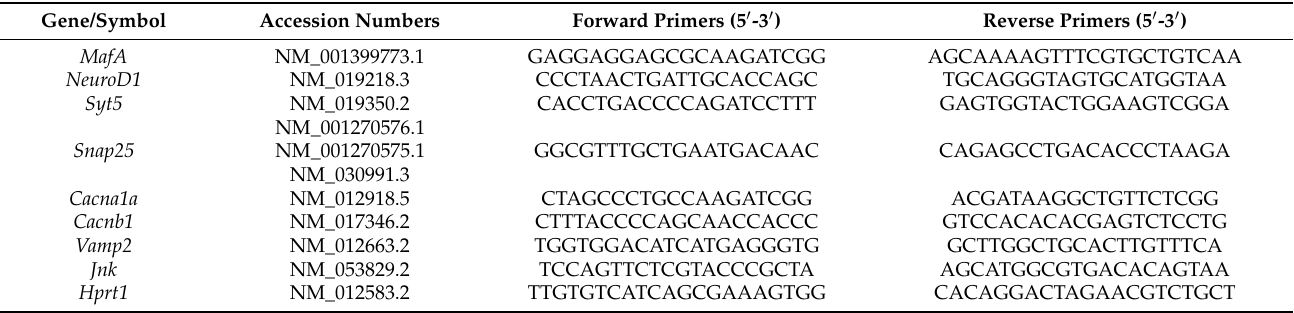
Table 1. SYBR green primer